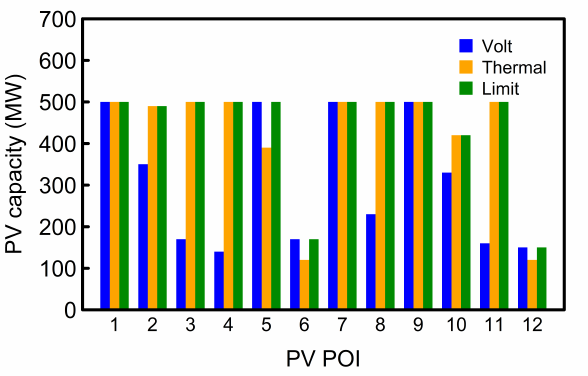
Figure 16. Maximum PV hosting capacity with respect to the circuit solution limit, voltage violation and thermal limits at peak load